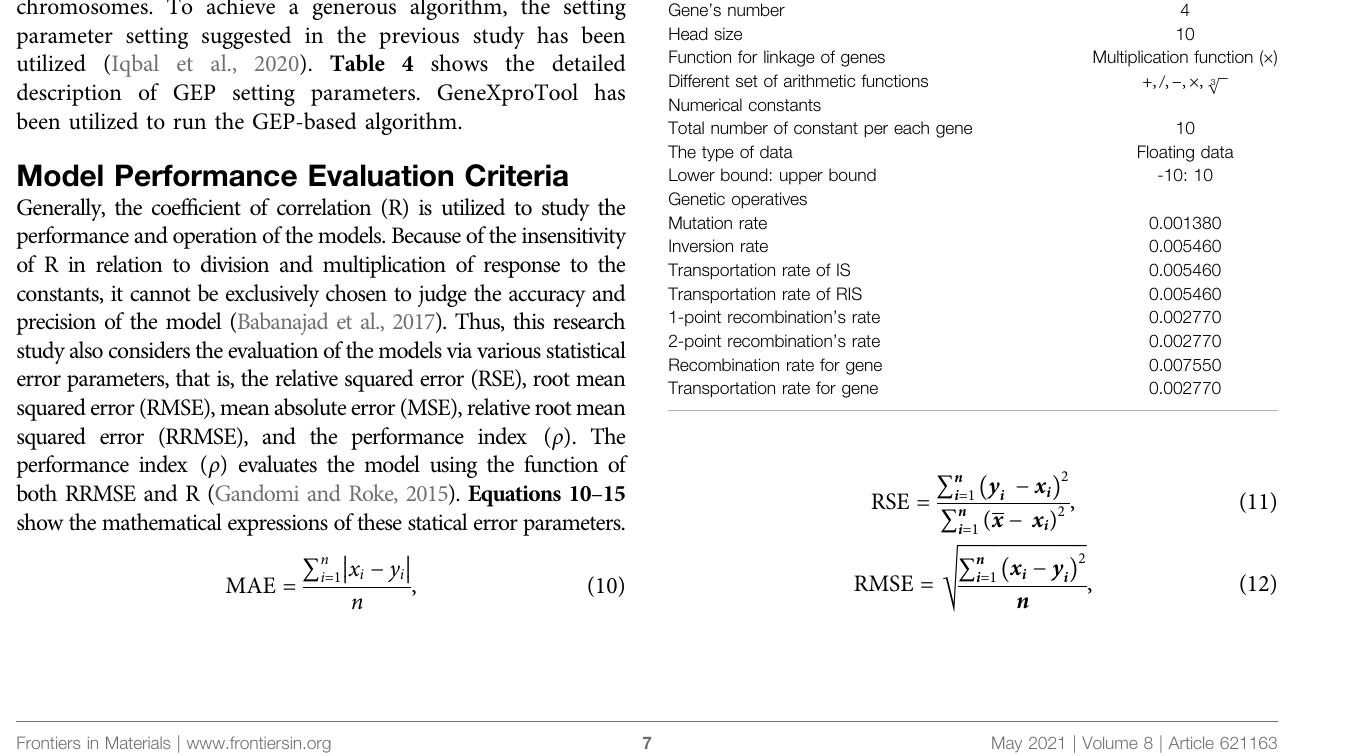
Function for linkage of genes Multiplication function ( × ) Different set of arithmetic functions + ,/, − , × , Numerical constants Total number of constant per each gene 10 The type of